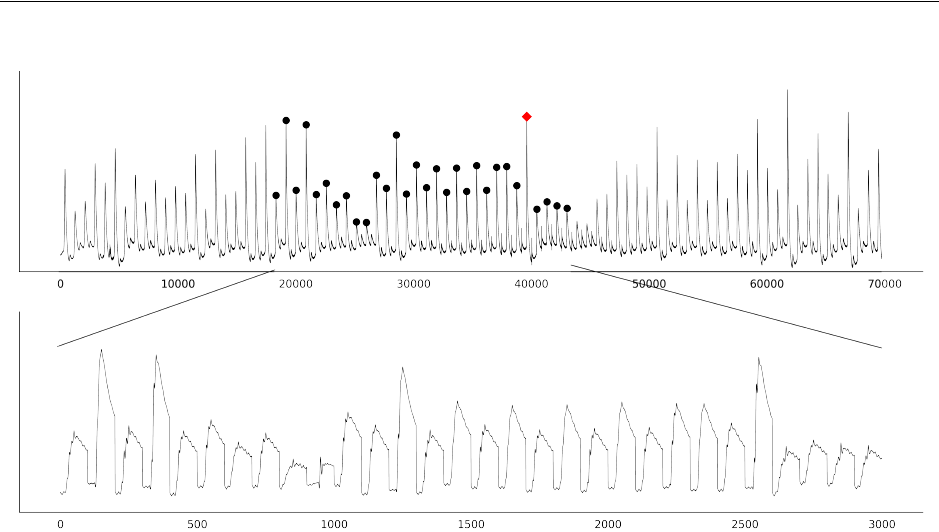
Figure 5: Average power trace over 1000 measurements (top). The traces were aligned on the highest peak close to time sample 40000, indicated by a red diamond. To achieve alignment across multiple devices we identified the peaks of interest (black dots) and selected 100 time samples around those to form artificial traces